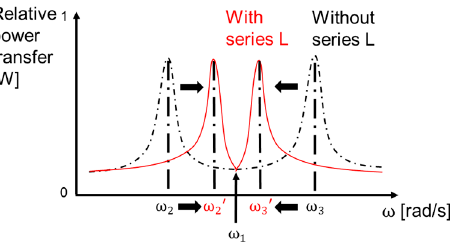
Figure 8. A conceptual graph showing the change in the MPT frequency according to the presence or absence of